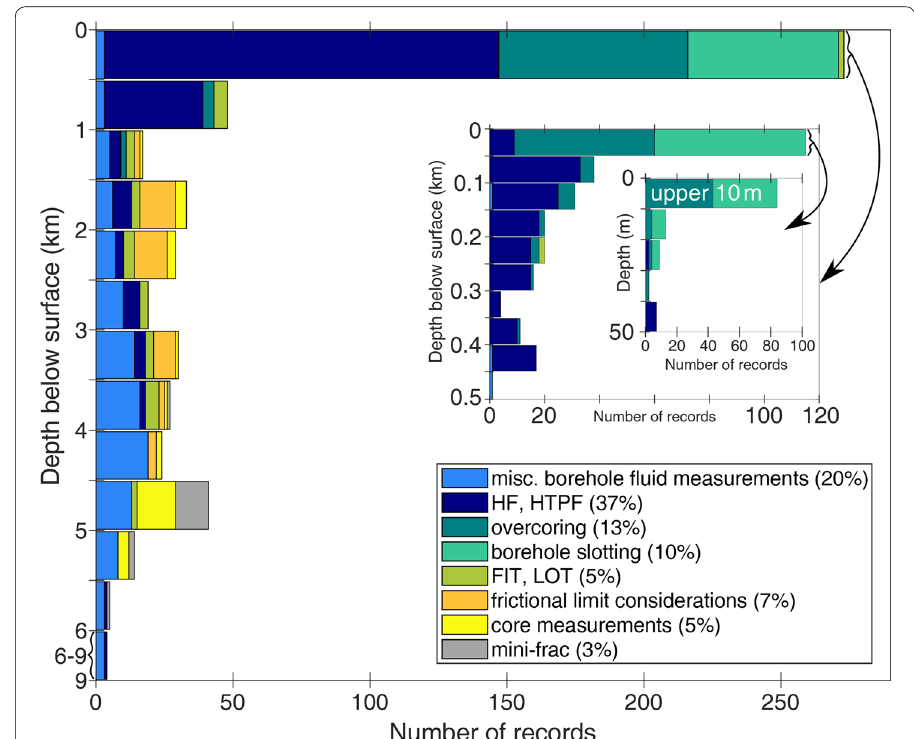
Fig. 6 Depth distribution of data records. The bars of the histograms are colour coded according to the type of stress magnitude indicator. The inset plots show the upper 500 m and 50 m below surface, respectively, in more detail and clarify the clustered appearance of the borehole slotting and overcoring measurements in shallow depths. The colour code corresponds to that used in Figs. 5a and 7. Percentages reflect the overall proportions of the different stress magnitude indicators. Considered are all data records for which depth information is available ( n 564). 273 data records are included in the larger inset histogram, 116 data = records are included in the smaller inset